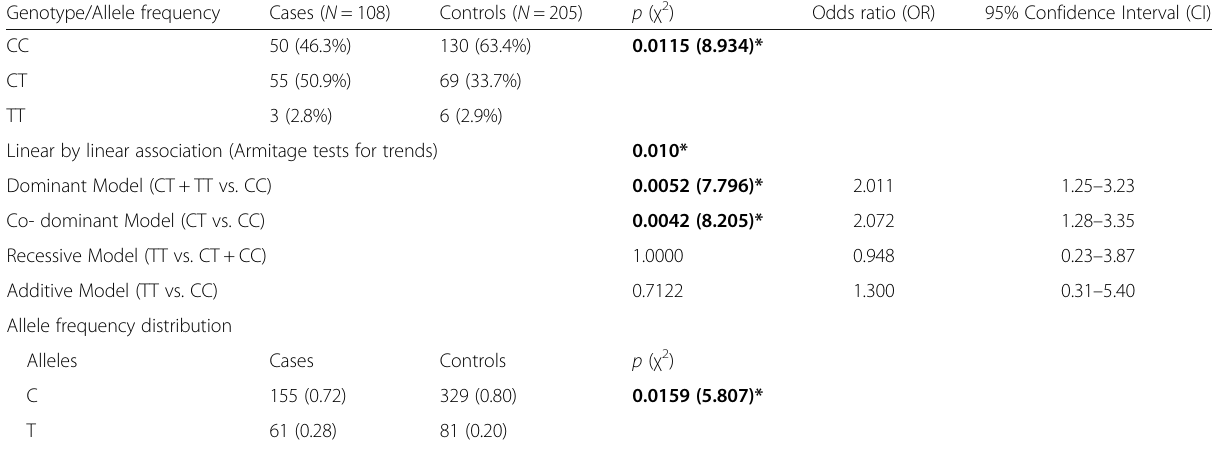
Table 3 Genotypic distribution of SLC1A3 C3590T (rs 2,269,272) in relation with Stress and